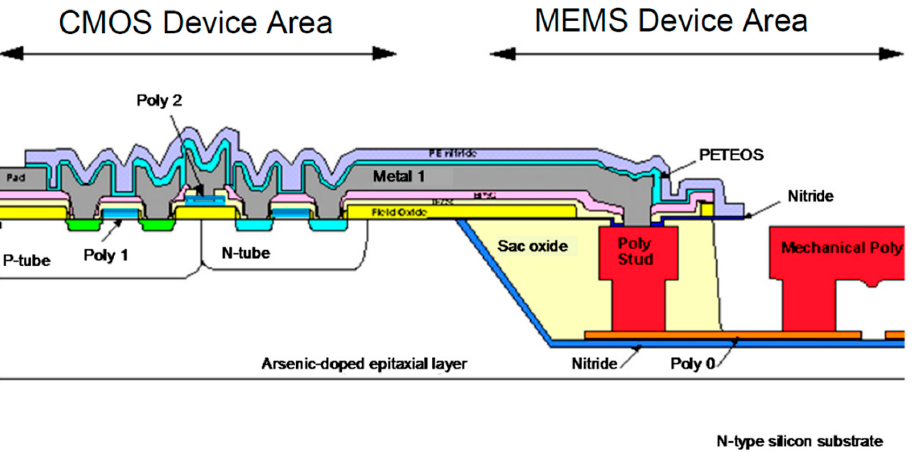
Figure 1. Cross-section of CMOS (complementary metal-oxide-semiconductor) and MEMS micro-electro-mechanical systems) in the recess trench in pre-CMOS integration [12].